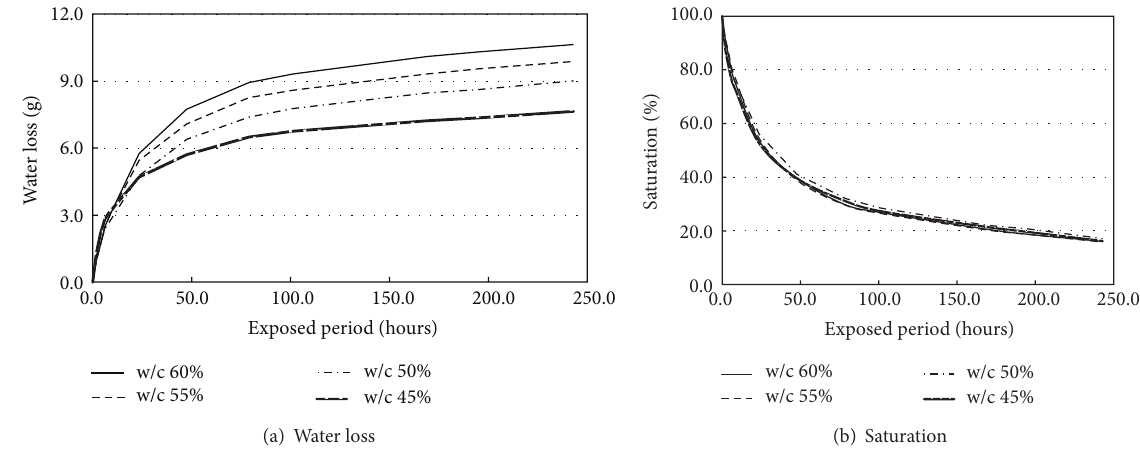
Figure 5: Water loss and saturation with W/C ratios.